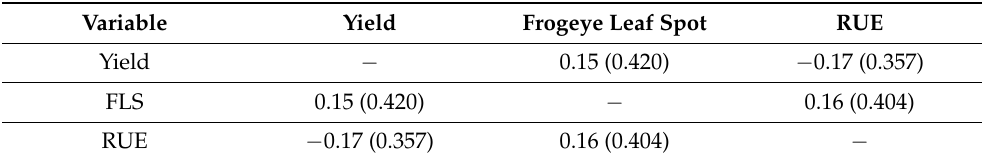
Table 9. Pearson’s rank correlations between yield, frogeye leaf spot, and radiation use efficiency (RUE) combined across years and locations. Variable Yield Frogeye Leaf Spot RUE Yield − 0.15 (0.420) − 0.17 (0.357) FLS 0.15 (0.420) − 0.16 (0.404) RUE − 0.17 (0.357) 0.16 (0.404)